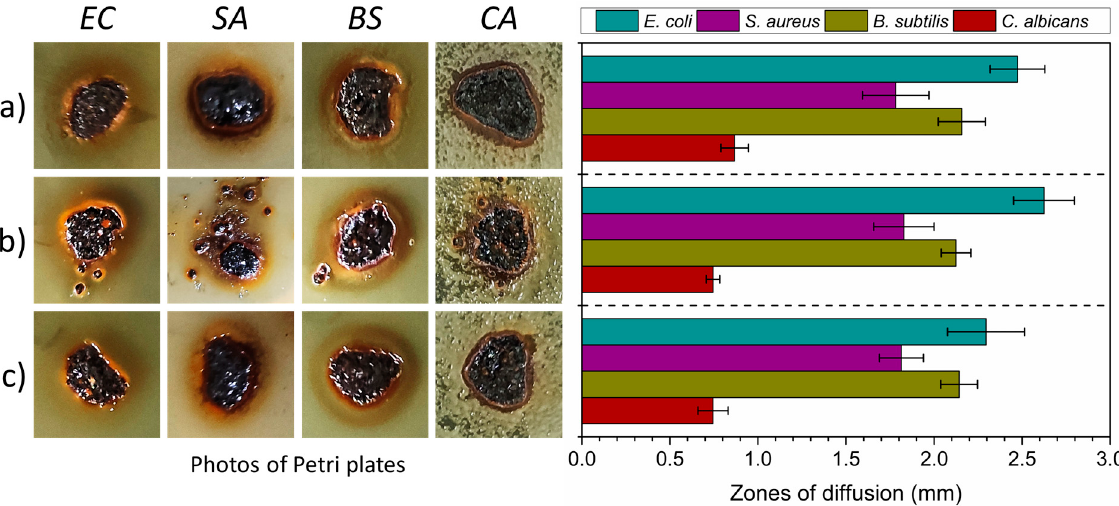
Figure 9. The results of diffusion studies performed for ( a ) reference ZVI, ( b ) ZVI after treatment of AM ACID at pH 3, and ( c ) ZVI after treatment of AM E123 at pH 3. The tests were performed with E. coli (EC), S. aureus (SA), B. subtilis (BS) bacteria, and yeast C. albicans (CA). The results are presented as photographs of Petri plates showing zones of diffusion (left side of the figure), and measured zones of diffusion (right side of the figure).